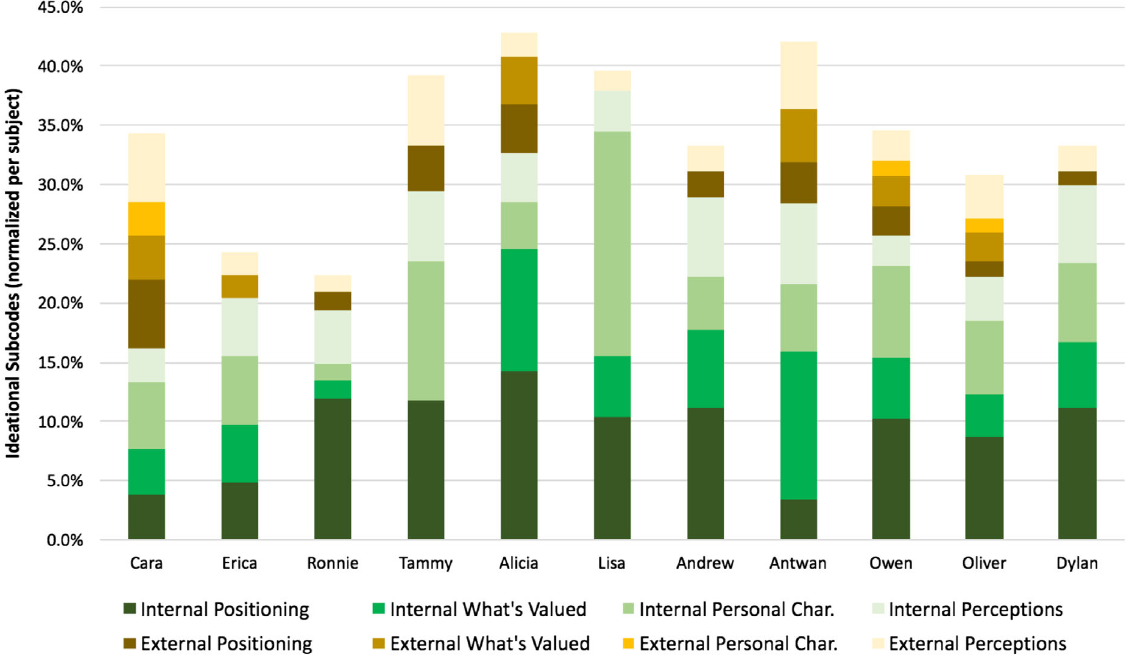
FIG. 3. Graph of the internal and external ideational codes for each participant, normalized to the total code counts for each individual interview. Shades of green represent internal subcodes and shades of brown represent external